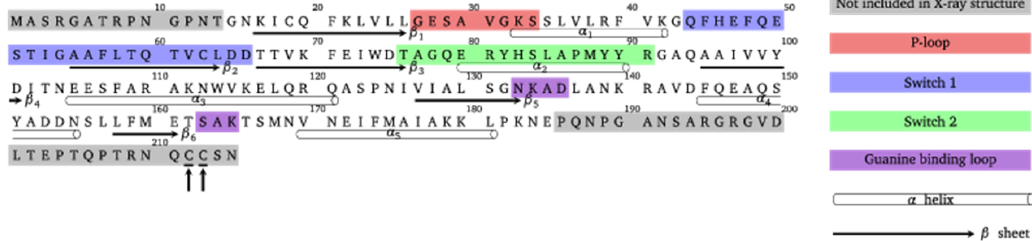
Figure 2. Amino acid sequence of the Rab5 protein and important functional regions. From the 215 residues, only the catalytic G domain structure from Gly15–Glu185 is experimentally resolved. The post-translationally attached geranylgeranyl chains are located at C-terminal residues Cys212 and Cys213 (marked with arrows).